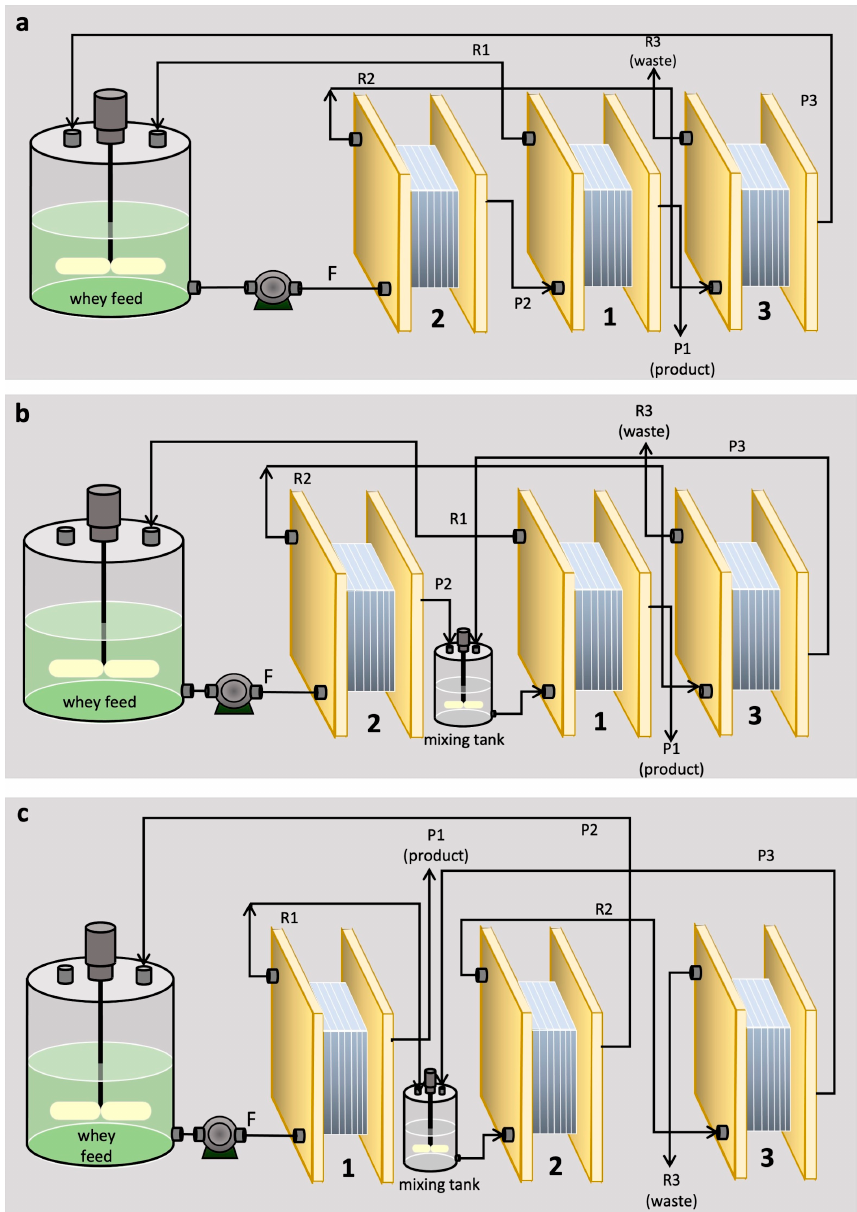
Figure 5. Cascaded UF with ( a ) non-constrained ideal; ( b ) adapted; and ( c ) countercurrent product recycle configuration. F: feed; P: permeate; R: retentate; W: waste. Integration of jet-cooking with enzyme-assisted UF was revealed to increase the protein content of soy protein isolate (SPI) and nitrogen solubility index (NSI) and reduce isoflavones and phytic acid for infant formula [173]. UF membrane of 80 kDa was se- lected attributed to (1) increase of permeate flux from 4 to 12 L m − 2 h − 1 , (2) slightly lower protein retention rate increase (<5% decline), (3) higher protein concentration in permeate (changed from 35 to 70 μ g mL − 1 ), and (4) decline of phytic acid from 2.1 to 1.2 μ g mL − 1 (all value compared between 30 kDa and 80 kDa, respectively). Jet-cooking temperature